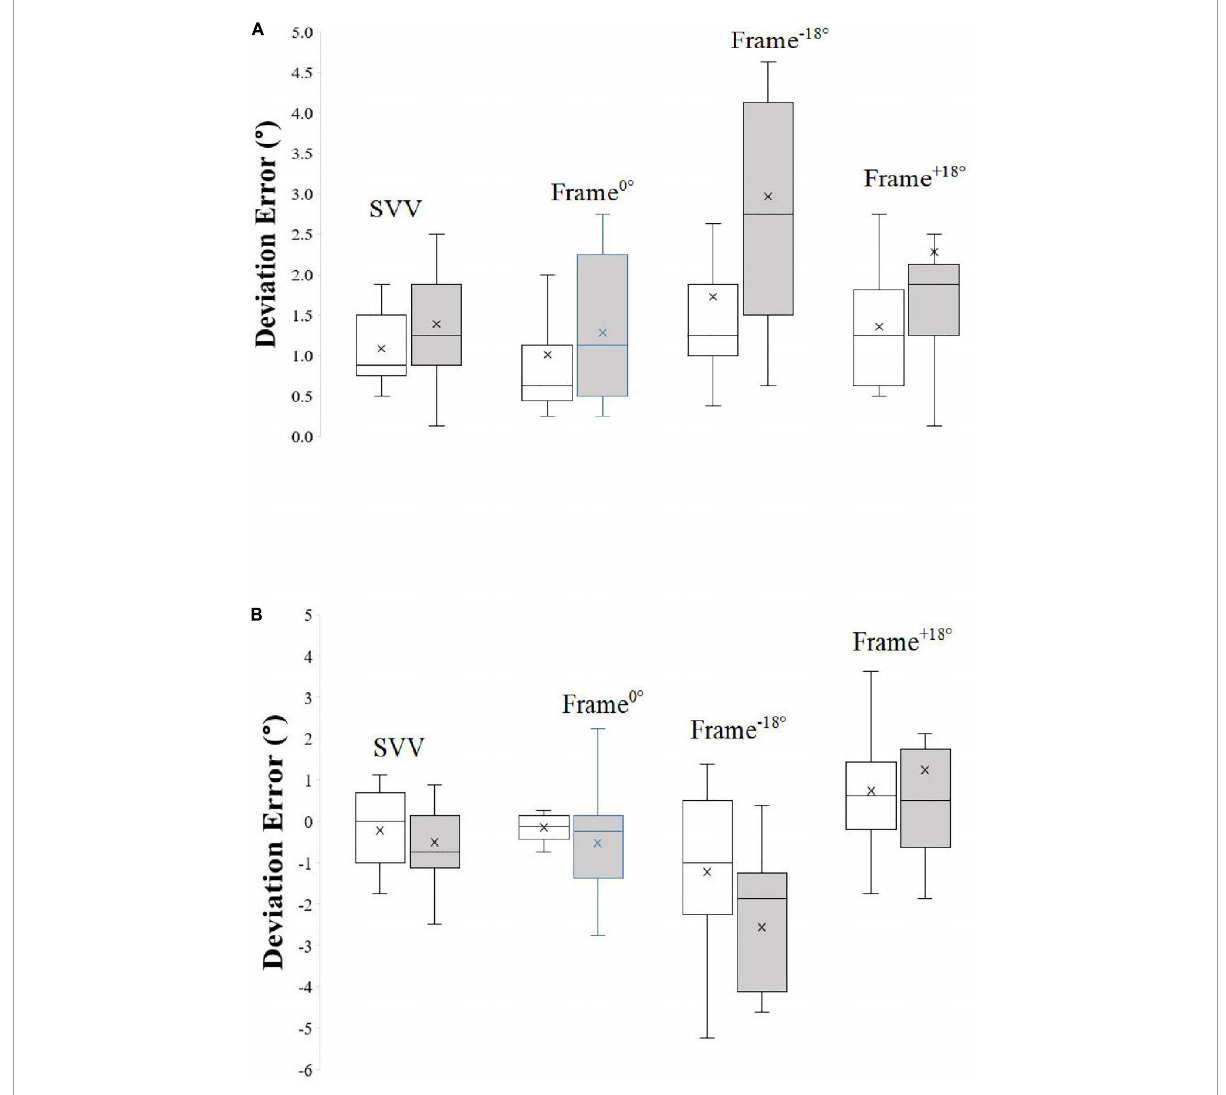
FIGURE3 Box and Whisker plots of unsigned (A) and signed (B) deviation error with median and interquartile range during different frame contexts in control participants and SCZ. “X” represents the mean of the data.